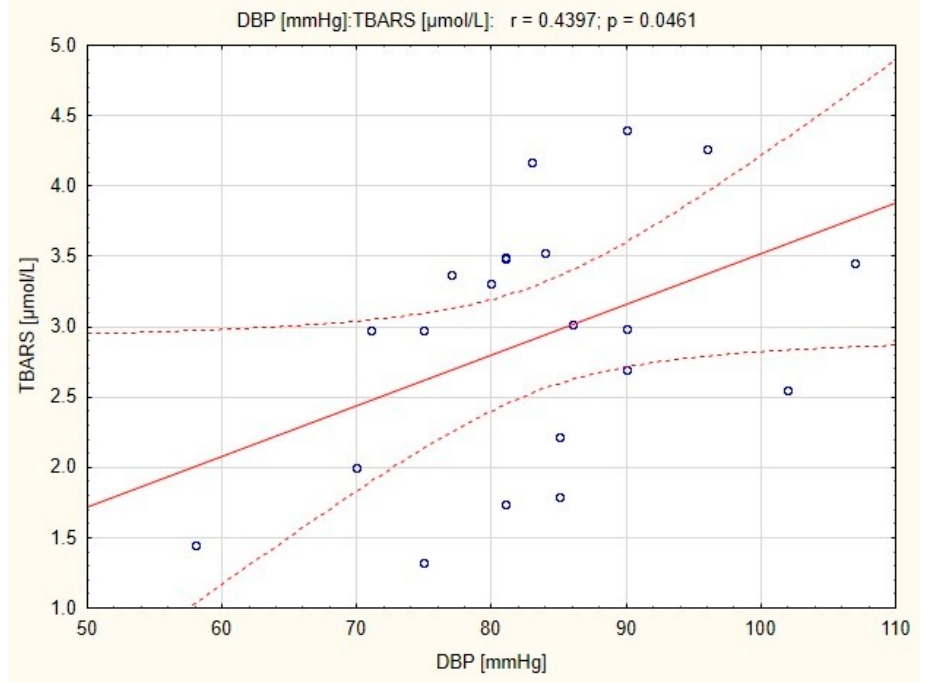
Figure 1. Correlation between resting diastolic blood pressure (DBP) and thiobarbituric acid reactive substances (TBARS) concentration in women with obesity before endurance training. Int. J. Environ. Res. Public Health 2019 , 16 , x FOR PEER REVIEW